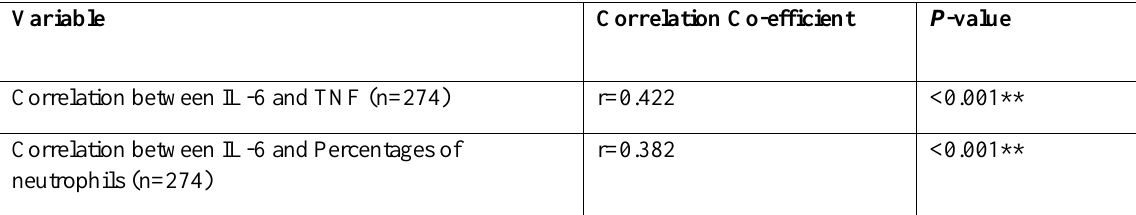
Table 3. Correlation of IL-6 with TNF-α serum levels and neutrophil blood counts in COVID-19 patients with different severities.